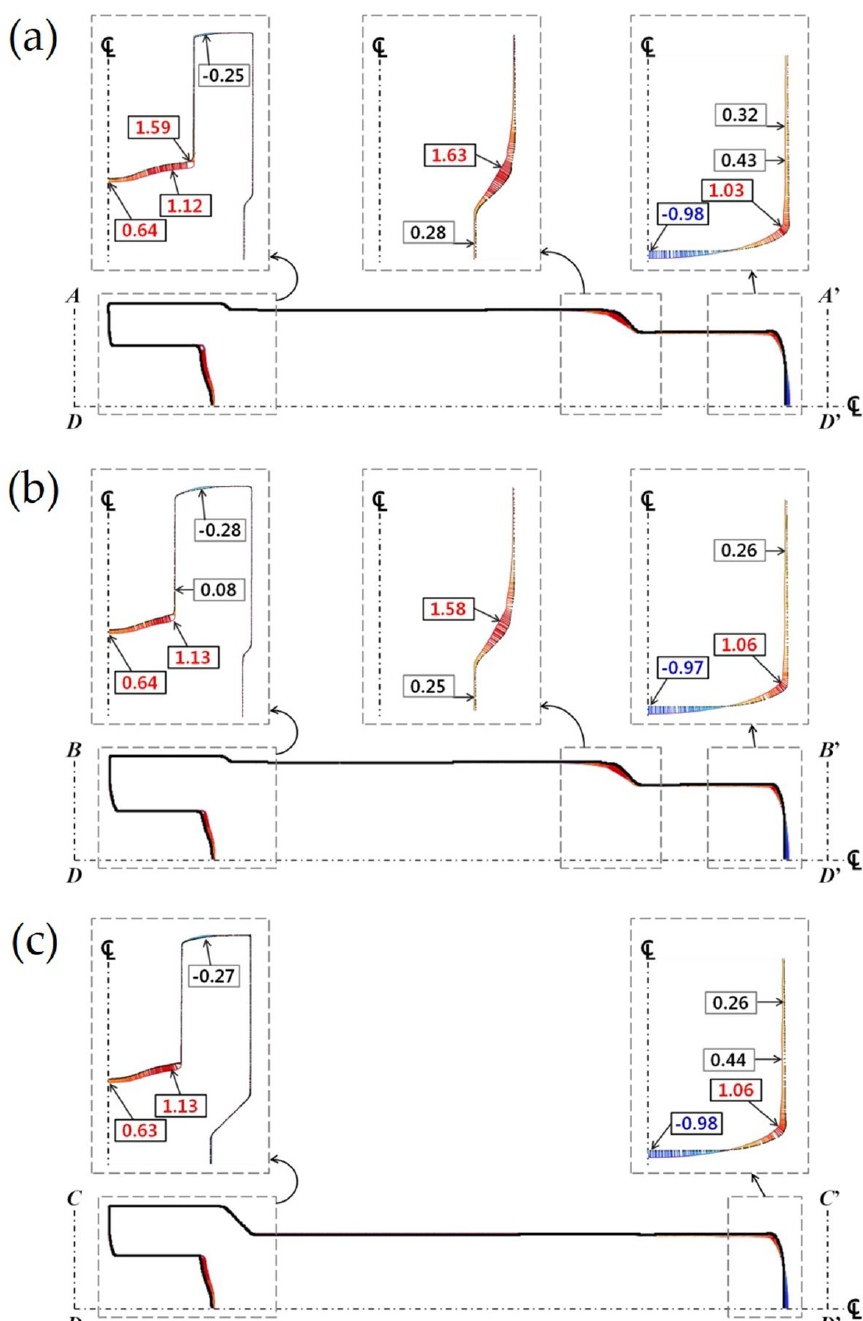
Figure 14. Dimensional variation between simulated layout and 3D scanned image of the drive shaft (unit: mm): ( a ) Shape comparison on DA - D ’ A ’ cross-sectional plane (top land direction); ( b ) Shape comparison on DB - D ’ B ’ cross-sectional plane (top land direction); ( c ) Shape comparison on DC - D ’ C ’ cross-sectional plane (bottom land direction).